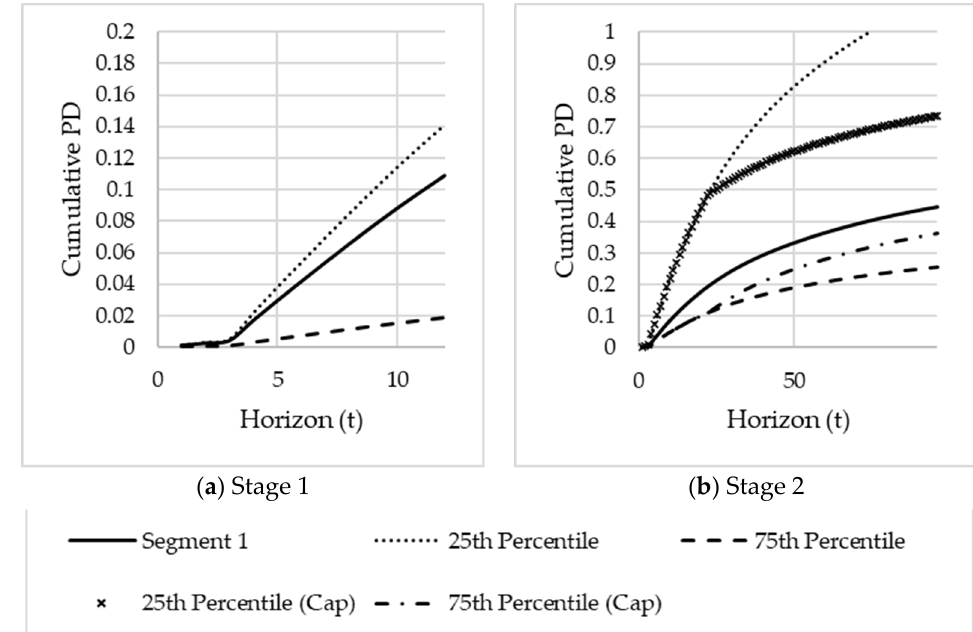
Figure 10. Adjusted cumulative PD term structure for Segment 1.